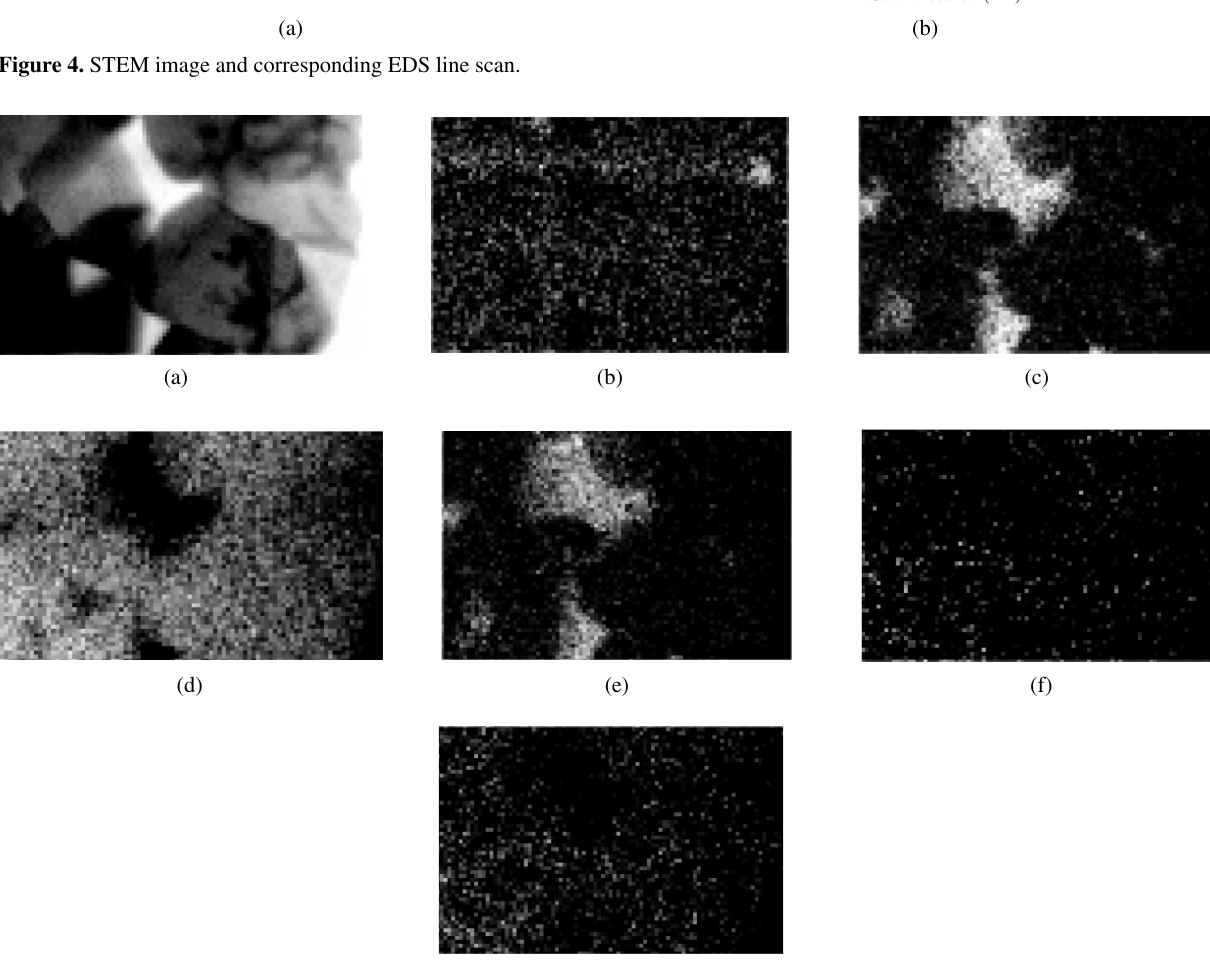
Figure 5. STEM image and EDS maps of W, Co, Nb, C and